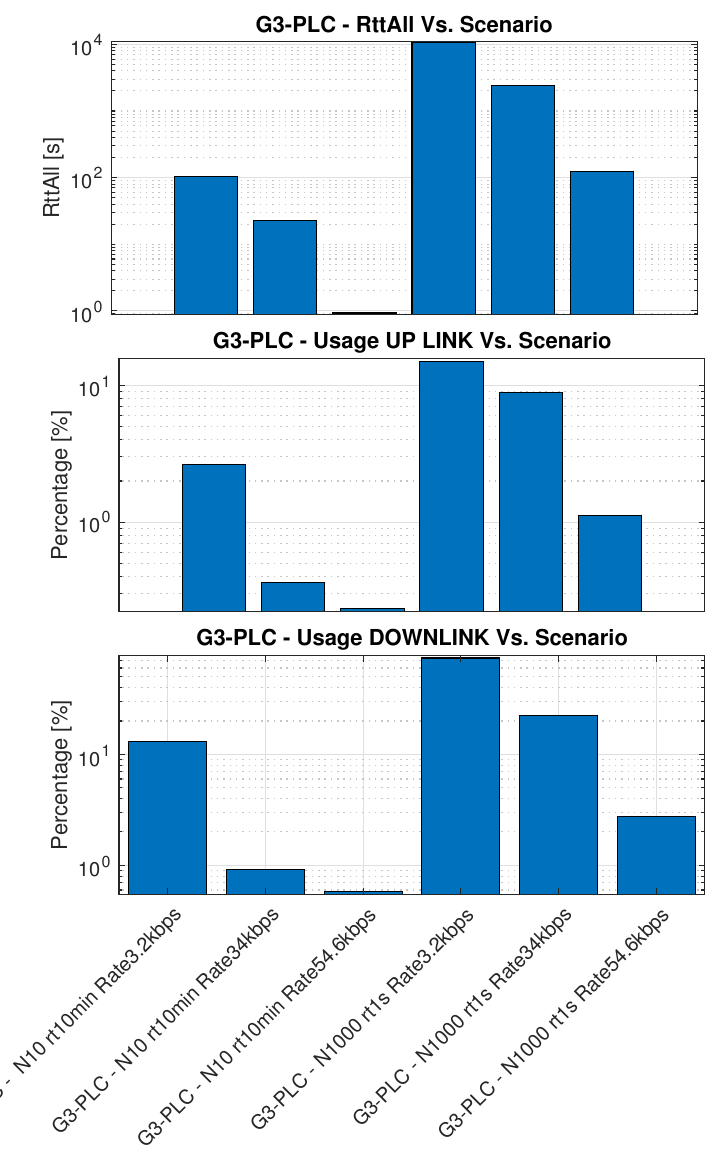
Figure 9. Usage on the up and down direction and RTTAll for Scenario